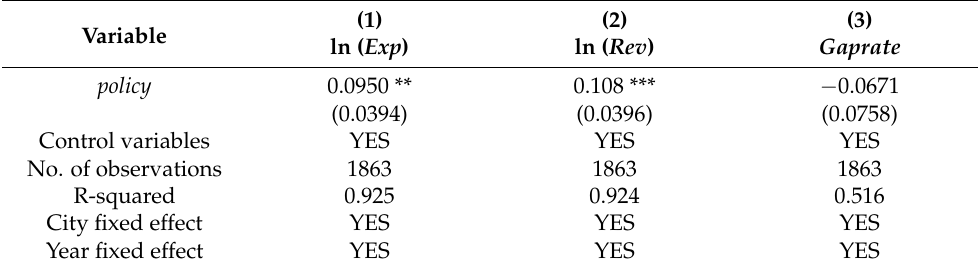
Table 8. Mechanism analysis—fiscal